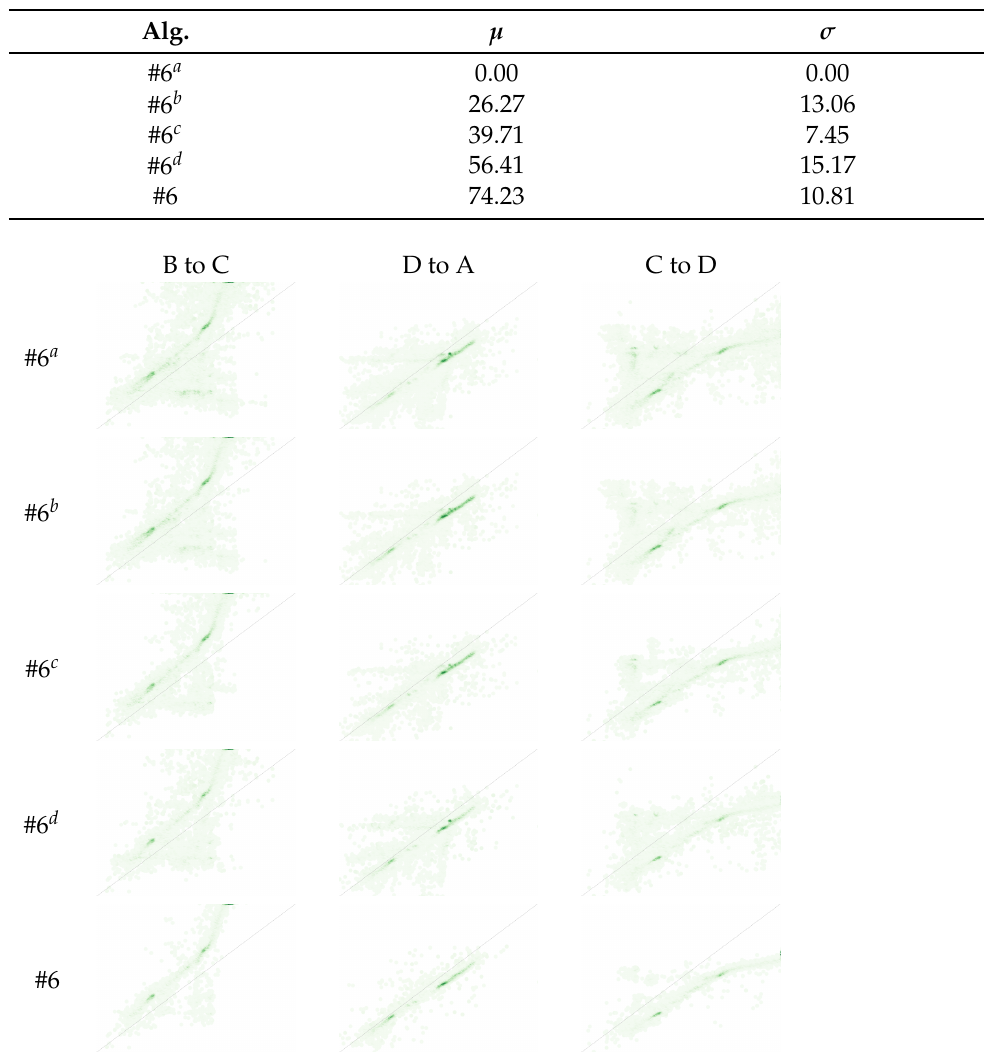
Figure 12. JIHs produced using the different variants of the proposed approach (rows). Each column represents the green channel of the JIH between a randomly chosen pair of images. For example, the first column, B to C, represents the green channel of the JIH between image B and image